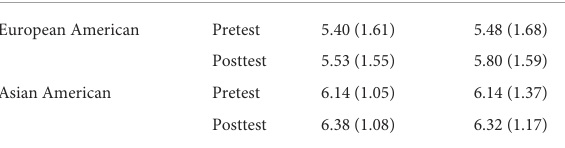
TABLE 1 Attitudinal outcomes by message frame and audience ethnicity.